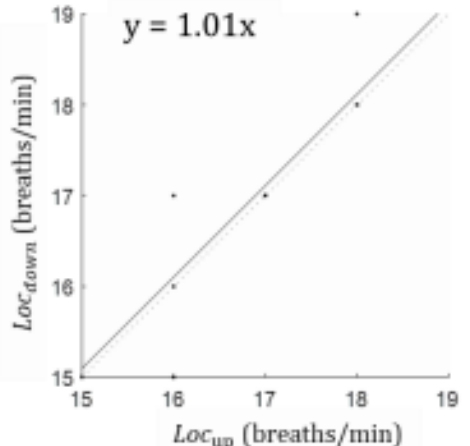
Figure 8. Bland-Altman results according to sensor location. Loc down : smartphone is located under the left foot; Loc up : smartphone is located next to the left shoulder.